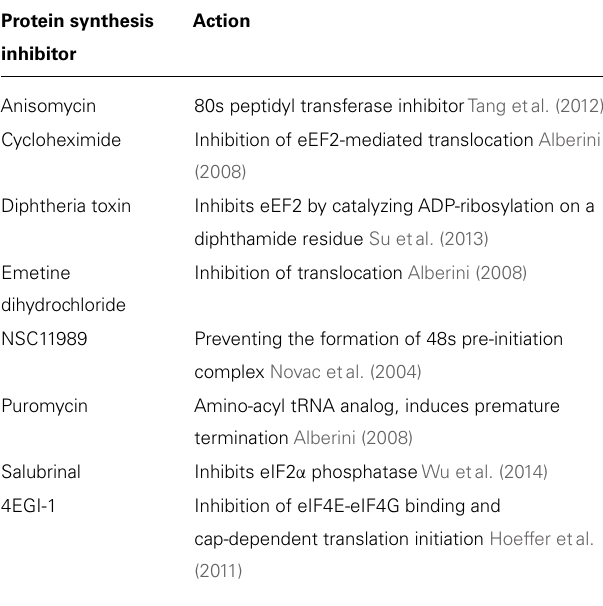
Table 1 | Protein synthesis inhibitors and their mechanism of